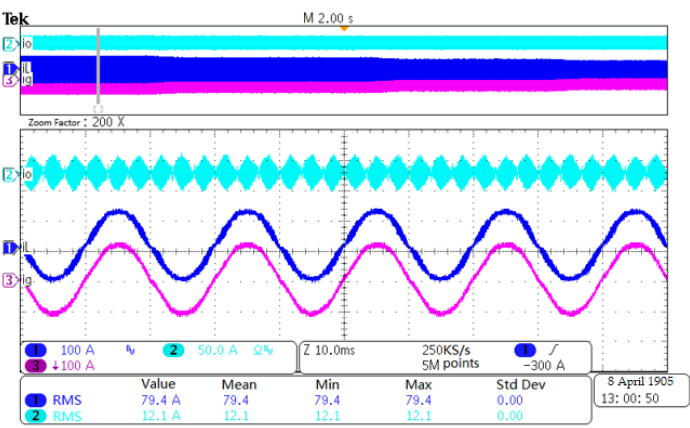
Figure 21. Waveform of i o , i L , and i g under 80A i L using PD.